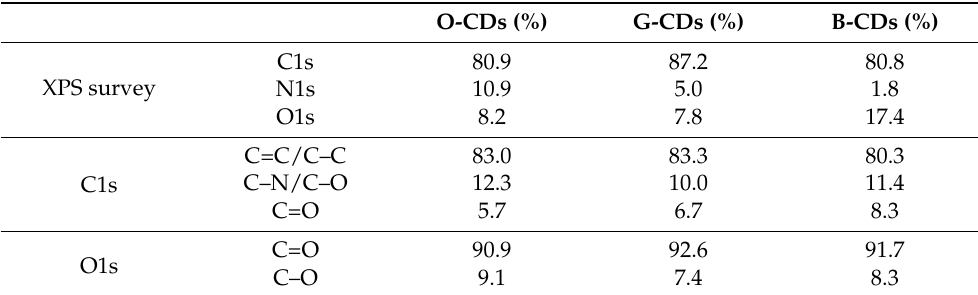
Table 2. XPS spectra data of O-CDs, G-CDs and B-CDs.